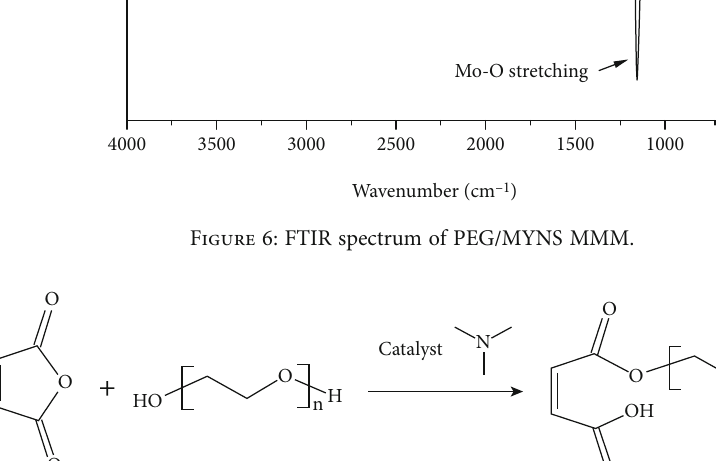
Scheme 1: Schematic representation of the crosslinking reaction of PEG with maleic anhydride.